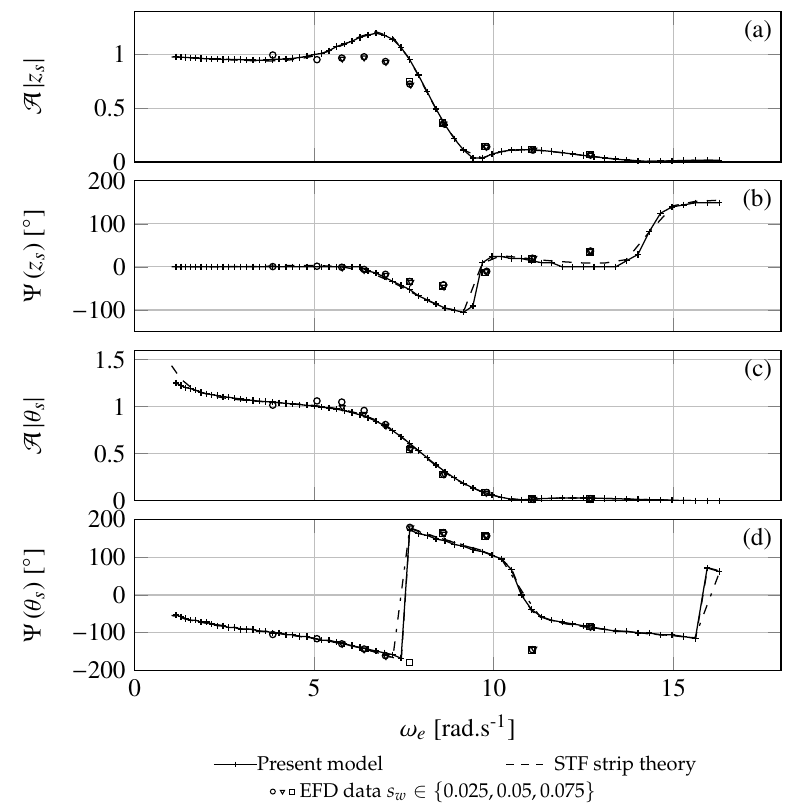
Figure 5. Heave and pitch transfer function at U = 1.53 m.s − 1 according to the frequency of encounter ω e . Amplitudes are plotted for heave ( a ) and pitch ( c ). Phases are plotted for heave ( b ) and pitch ( d ). The results are obtained with the frequency domain and time domain approaches, experimental data for different wave steepness s w and with the STF strip